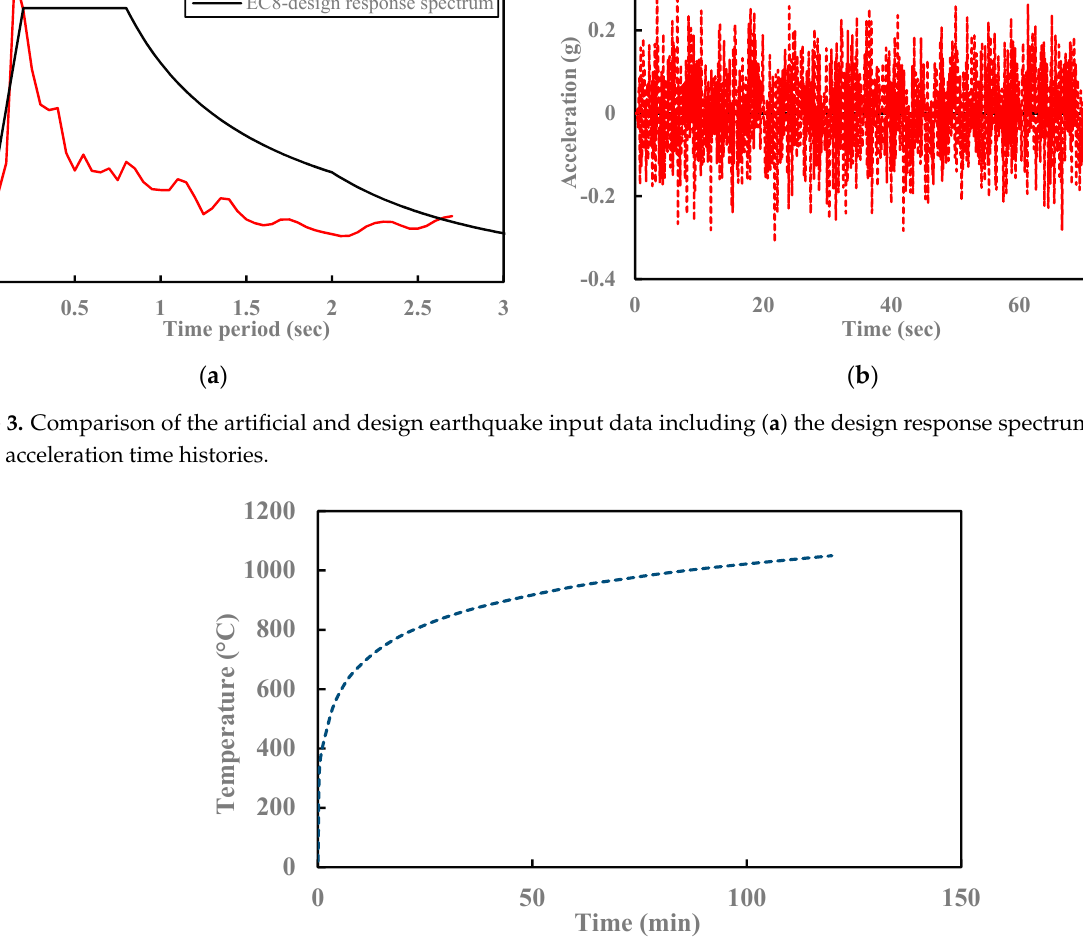
Figure 4. Standard fire curve [7].